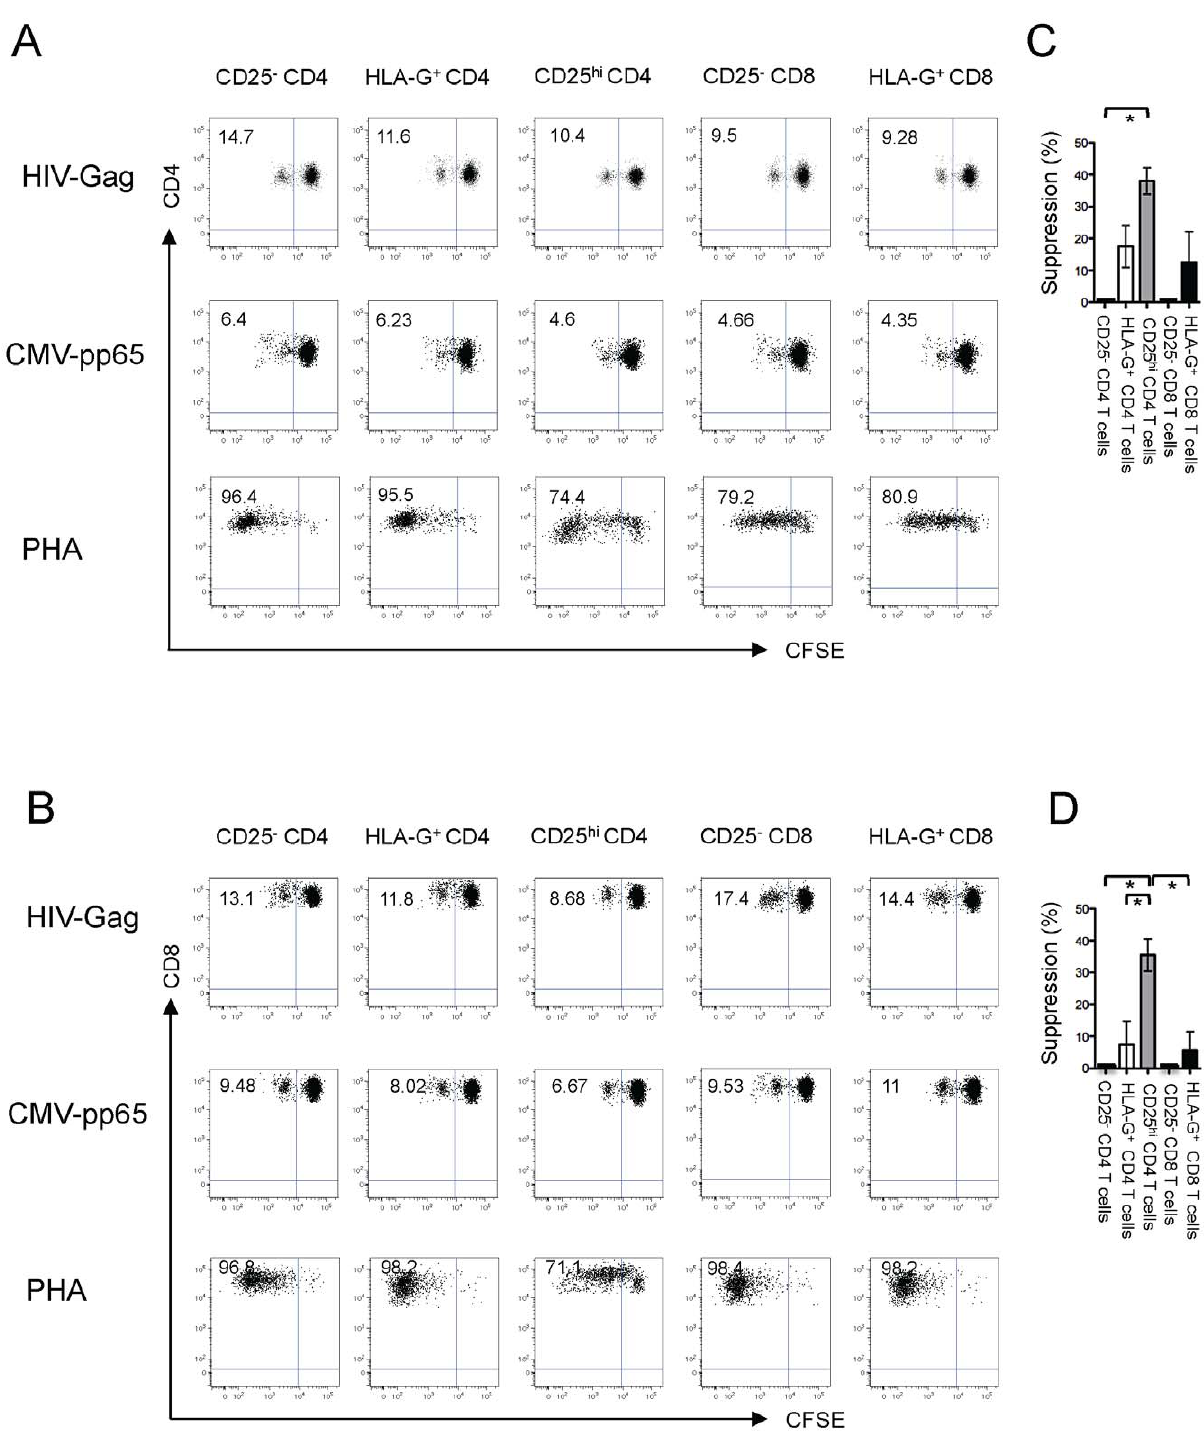
Figure 3. HLA-G + Treg minimally inhibit proliferative activities of antigen-specific T cells. (A–B): Representative dot plots reflecting proliferative activities of HIV-1-, CMV-, or PHA-stimulated CD4 (A) or CD8 (B) T cells from HIV controllers following incubation with indicated autologous Treg subsets or HLA-G 2 CD25 2 control cells. (C–D): Cumulative data reflecting the Treg-mediated suppression of HIV-1-specific CD4 (C) or CD8 (D) T cell proliferation from n=3 HIV-1 controllers. Significance was tested by paired T test. doi:10.1371/journal.ppat.1003140.g003 prior reports about the immunosuppressive properties these cells [5]. expressing and V b 13.1-negativeT cells.Asdemonstrated inFigure 4, In contrast, HLA-G-expressing Treg led to a significantly reduced we observed that classical CD25 hi Treg potently suppressed CD38/ HLA-DR expression in V b 13.1-negative T cells, consistent with surface expression of CD38 on V b 13.1-expressing T cells, but had